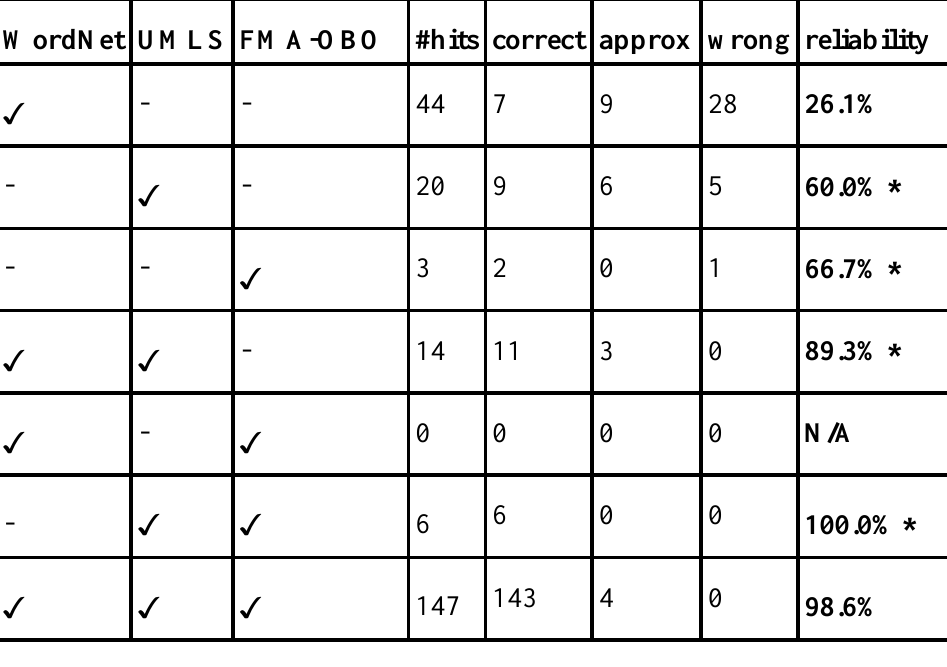
Table 2: Reliability by source. * denotes reliability scores in categories < 30 hits.